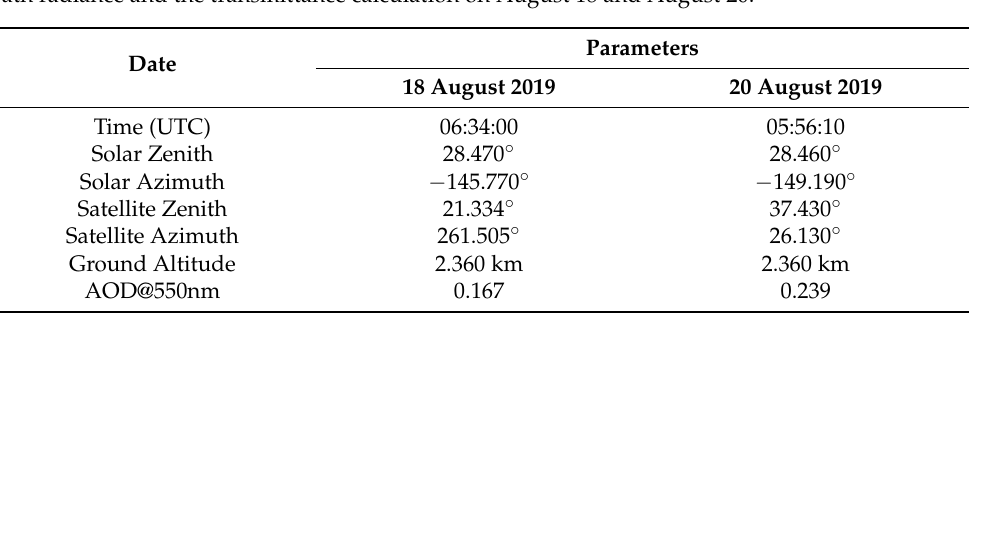
Figure 4. Relative spectral response of the FY − 3D MERSI-II (channel 24 and channel 25) and the CE312 bands (band 3 and band 2). Table 2. Input parameters of moderate resolution atmospheric transmission (MODTRAN) 4.2 for the path radiance and the transmittance calculation on August 18 and August